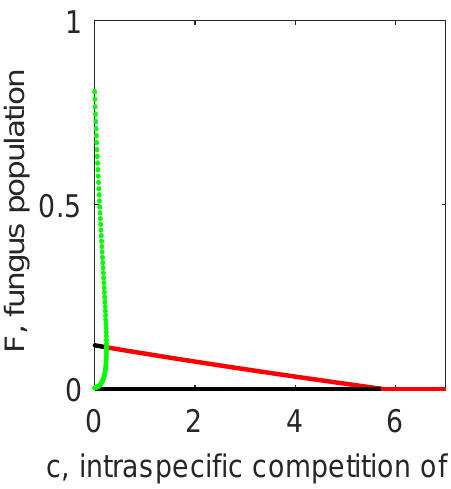
Fig. 5 One parameter bifurcation analysis of the populations N , E and F of the system (1) in terms of the parameter c , respectively. The continuous red curves represent the stable equilibrium points and the black one the unstable ones. The dotted green curve represent the maximum and minimum values of the oscillations triggered by the Hopf bifurcation. The other parameters values are β = 10, q = 1, γ = 5, b = 0 . 002, a = 2 and p = 1 . 2. The initial conditions are N = 1, E = 1 and F =